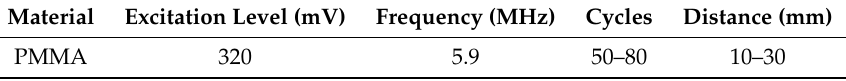
Table 1. Selected parameters to measure the nonlinear parameter in PMMA.